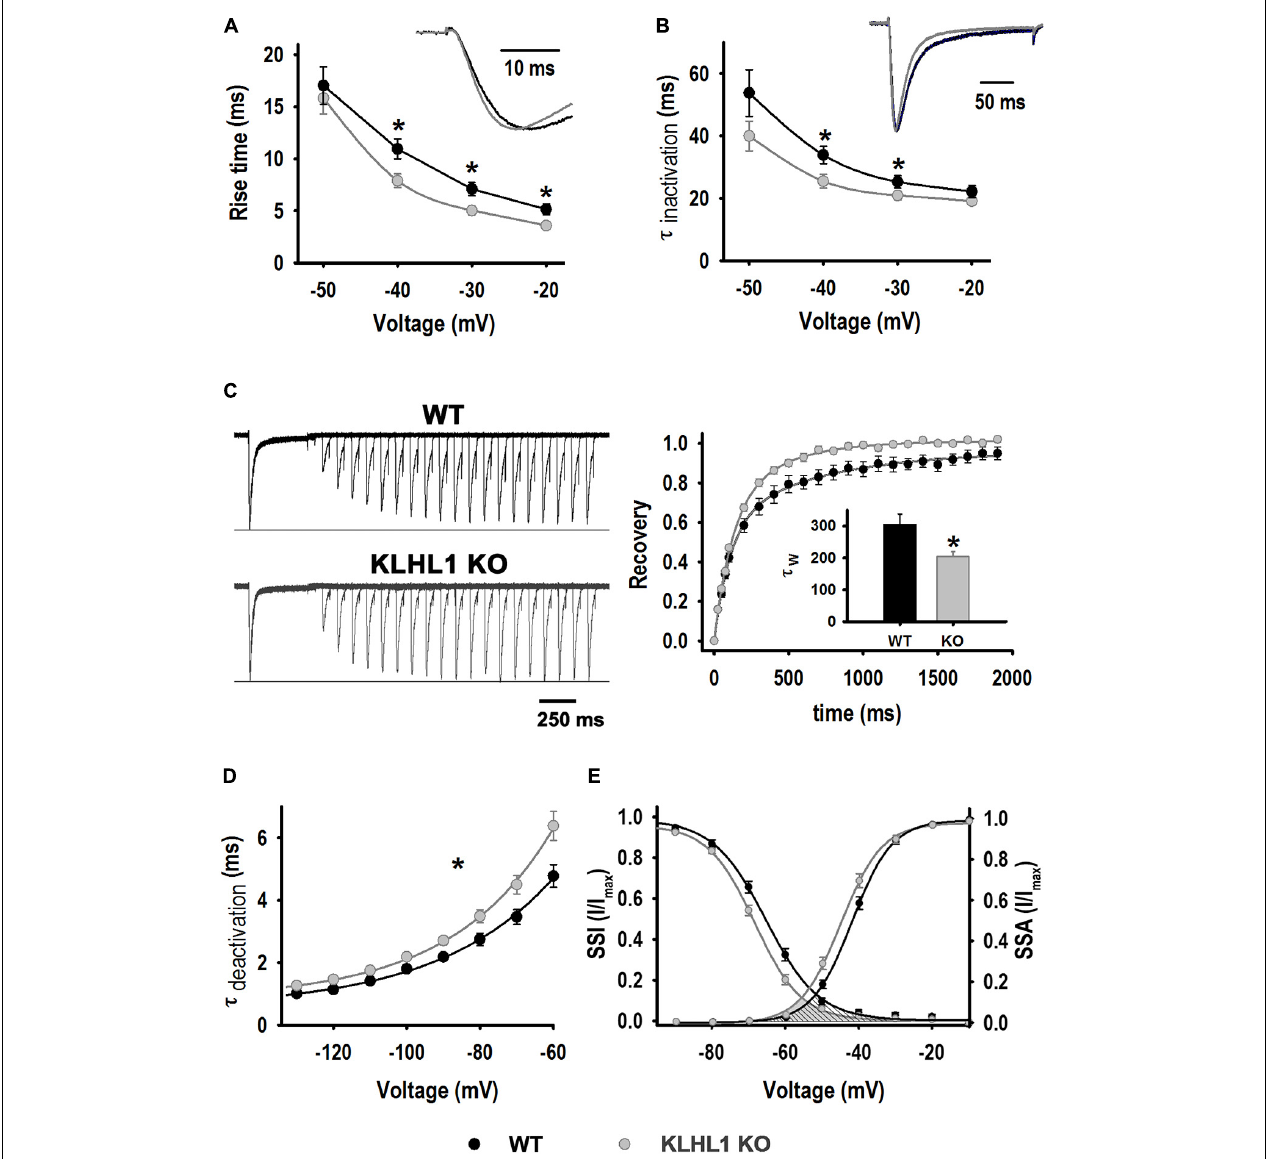
FIGURE 3 | LVA current properties. (A) Activation kinetics. Time taken by the current to change from 10% to 90% [Rise time (10–90%)] as function of voltage for WT ( n = 21) and K-LHL1-KO ( n = 26) neurons. * P < 0.05, t -test, for –40 mV: t = 2.723 (df = 45), for –30 mV: t = 2.743 (df = 45) and for –20 mV: t = 2.735 (df = 45). (B) Time constant of inactivation ( τ inactivation ) as function of voltage for WT ( n = 21) and KLHL1-KO ( n = 25) neurons. * P < 0.05, t -test, for –40 mV: t = 2.432 (df = 45), for –30 mV: t = 1.807 (df = 45). (C) Right: Trace examples of recovery rate from inactivation. Left: % recovery vs. recovery time ( n = 10 for WT and n = 11 for KLHL1 KO). Inset: Recovery time constant ( τ W ) values. * P < 0.05, t -test, t = 2.719 (df = 19). (D) Time constant of deactivation ( τ deactivation ) for WT ( n = 16) and KO ( n = 23) neurons. * P < 0.05 at all voltage tested, t -test: t = 2.515 (–60 mV), t = 2.488 (–70 mV), t = 2.419 (–80 mV), t = 2.666 (–90 mV), t = 2.405 (–100 mV), t = 2.757